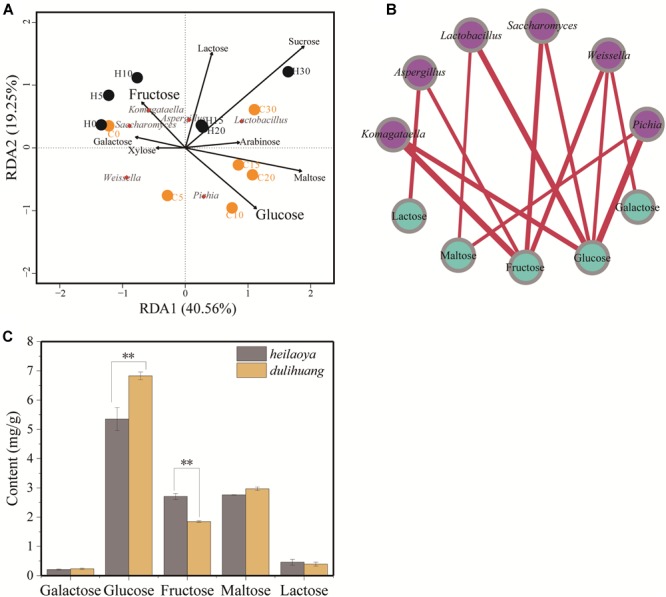
The composition of sugar profile and their association with flavor-producing microbiota succession. (A) Redundancy analysis (RDA) based on flavor-producing microbiota and sugar profiles in fermented grains. Fermentation time is shown as 0 to 30, e.g., “0” represents the sample fermented for day 0. H and C represents heilaoya and dulihuang, respectively. (B) Relationships between sugar profile and flavor-producing microbiota. A connection stands for a significant (P < 0.05) correlation. Size of each node is proportional to the number of connections, and the nodes are colored by blue (sugar) and purple (genus). The thickness of each connection between two nodes is proportional to the value of Spearman’s correlation coefficient (ρ). (C) Content of different sugars in hulless barley. Significant differences P< 0.01 (Students t-test) between heilaoya and dulihuang is denoted by ∗∗.